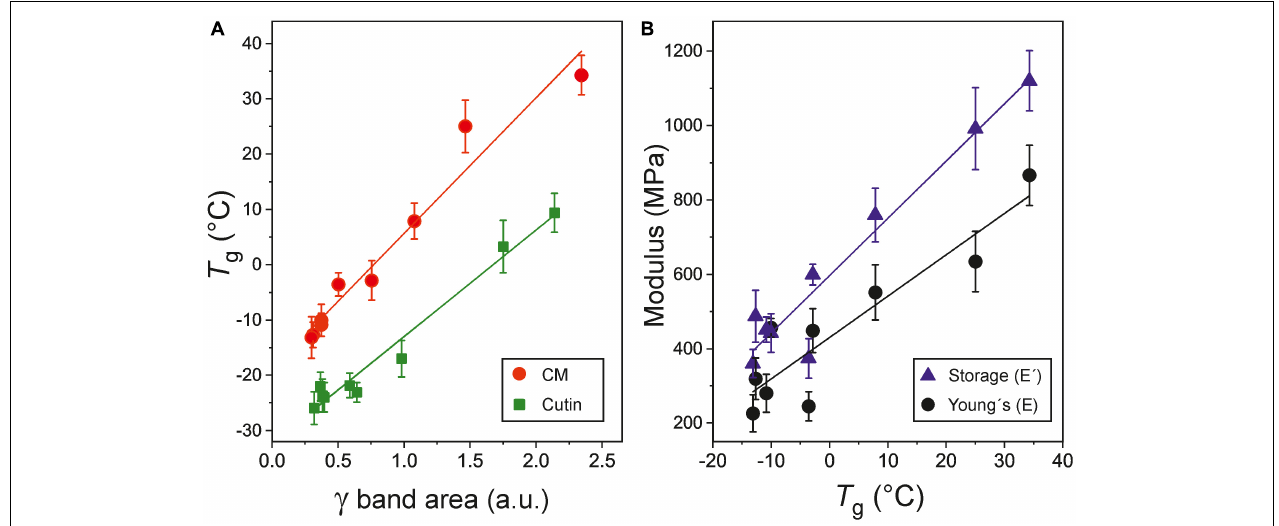
FIGURE 5 | (A) Correlation between the glass transition temperature ( T g ) and phenolics content, as monitored by the ATR-FTIR γ band, in CMs and cutins of tomato fruit. (B) Direct relationship between the Young’s (E) and storage (E (cid:48) ) moduli and the glass transition temperature ( T g ) in tomato fruit cuticle membranes. Error bars represent ± 1